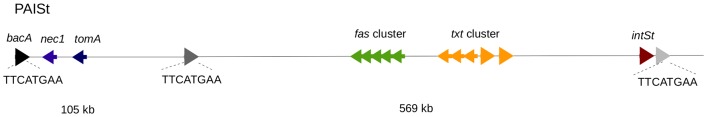
Schematic representation of the PAISt in S. turgidiscabies Car8.Copies of the 3′ end of the bacitracin resistance gene (bacA) delimit the element in two modules of 105 Kb and 569 Kb. The virulence genes nec1 and tomA are located in the first module and the fasciation (fas) and thaxtomin (txt) biosynthetic clusters are located in the second module. The putative integrase (intSt) is located at the 3′ end of the island. The 8 bp palidromic repeats are shown within the bacA gene and its truncated copies.